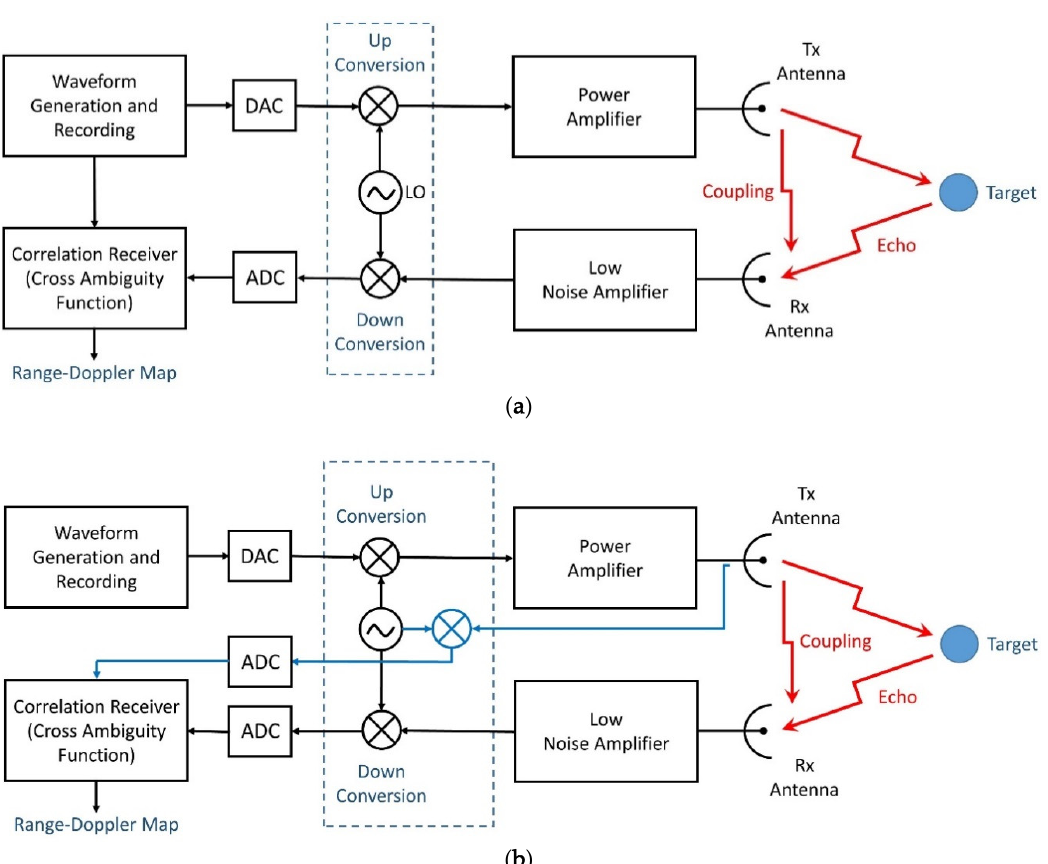
Figure 2. Basic Block Diagram. ( a ) The reference is the digital record of the transmitted code; ( b ) the reference is the record of the transmitted signal at the antenna port; ADC = Analog-to-Digital-Converter; DAC = Digital-to-Analog-Converter.